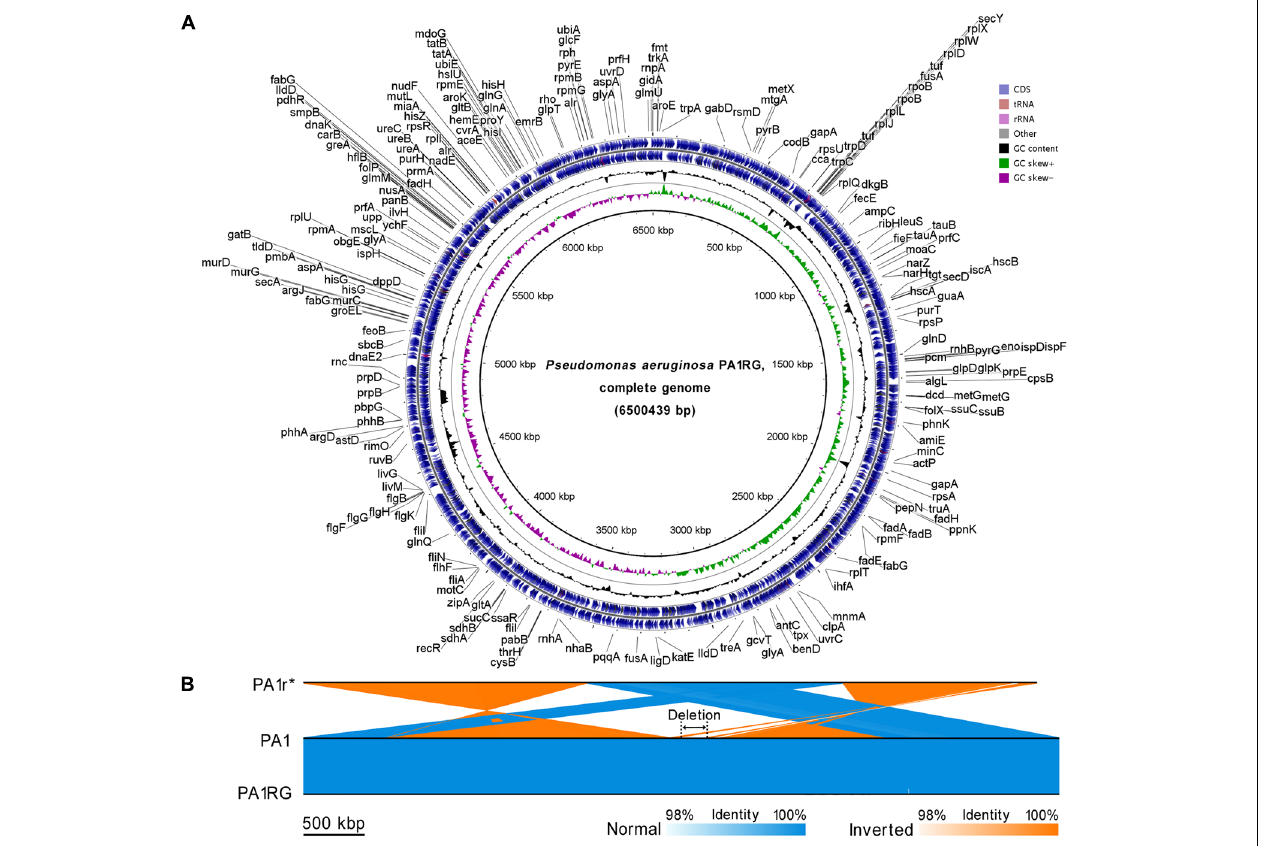
FIGURE 2 | Circular presentation and pairwise comparison of the PA1RG genome. (A) Diagram of the P. aeruginosa PA1RG genome. The names of 218 annotated genes (also shown in the GenBank file of the PA1RG genome) were indicated in black in the outermost region. The outermost ring depicts the genes on the plus strand, followed by rings depicting the genes on the minus strand, the GC content (black), and GC skew (green/purple). (B) Pairwise nucleotide sequence comparison of PA1r, PA1, and PA1RG. The length of the deletion region is 219.6 kb. ∗ In the GenBank file, the name of the Red mutant is PA1R, which is identical to